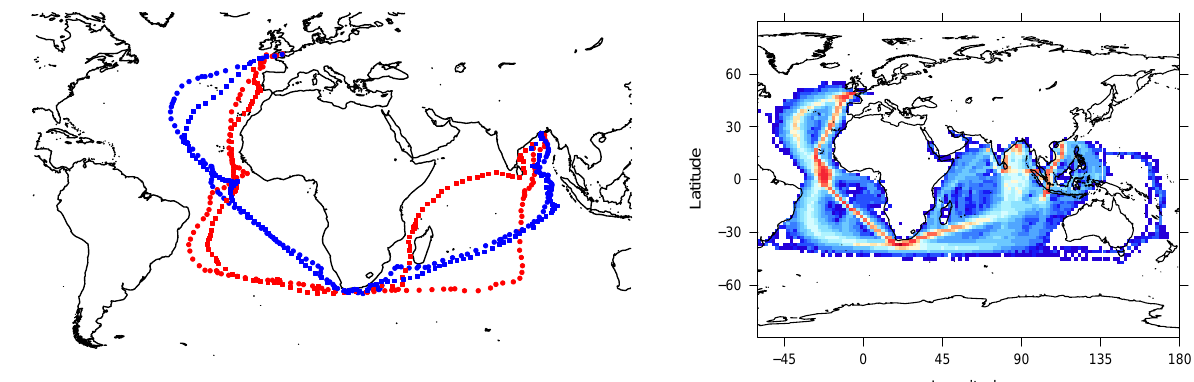
Fig. 5. Air temperature (AT) anomalies ( ◦ C ): observations minus an air-temperature climatology for 1961–90 (Rayner et al., 2003). Upper panel: truncated mean AT anomaly in each 2x2 degree square. Lower panel: truncated mean AT anomaly in each year. Note that the observed temperatures are not bias-adjusted.